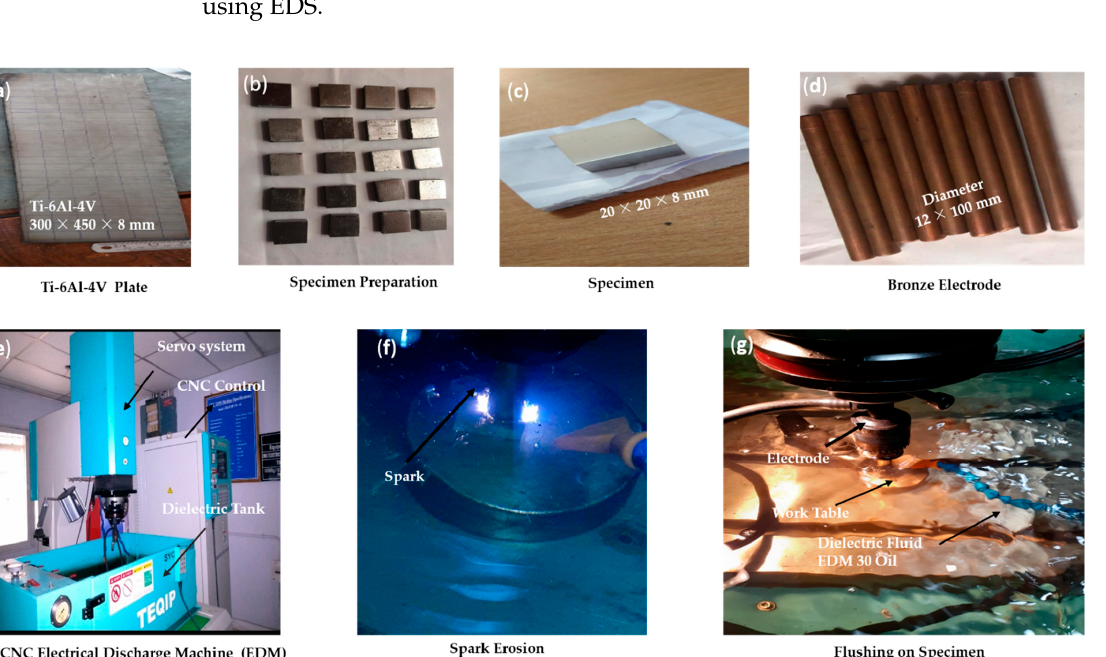
Table 3. Combination of machining process parameters.